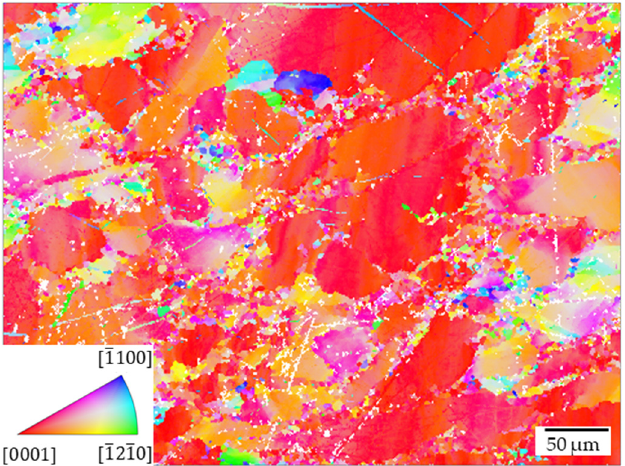
Figure 14. EBSD measurement of the transformed AZ31 magnesium alloy point II (300 °C, 0.01 s − 1 ): necklace along the grain boundaries, typical DDRX.